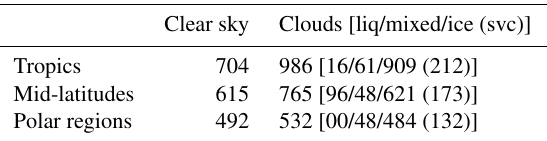
Table 3. Number of clear and cloudy simulated spectra for each lat- itude belt. Indicated in brackets is the number of liquid water clouds (liq), mixed-phase clouds (mixed), and ice clouds (ice) and, among these, the number of sub-visible cirrus clouds (svc), consisting of high-altitude cirri with optical depths less than 0.03, are shown in